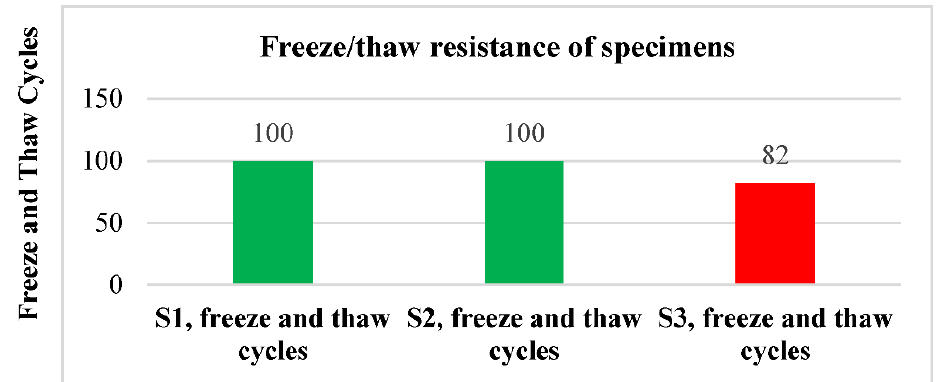
Figure 8. Results of freeze/thaw resistance.